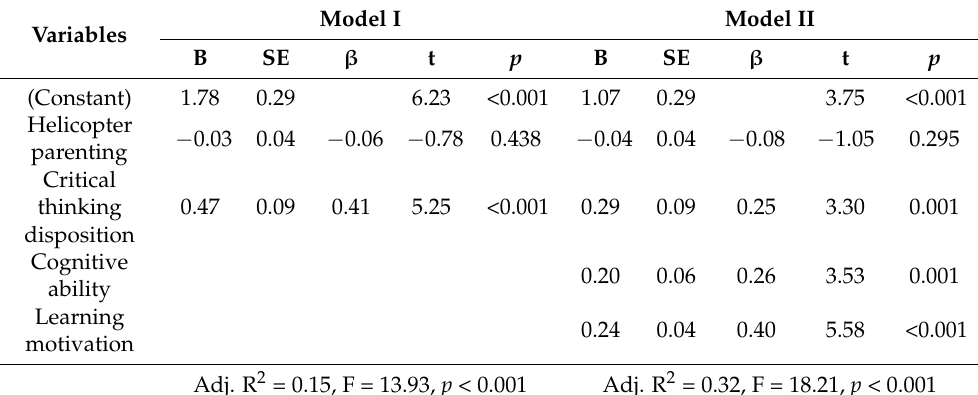
Table 4. Factors affecting learning behavior among participants ( n =